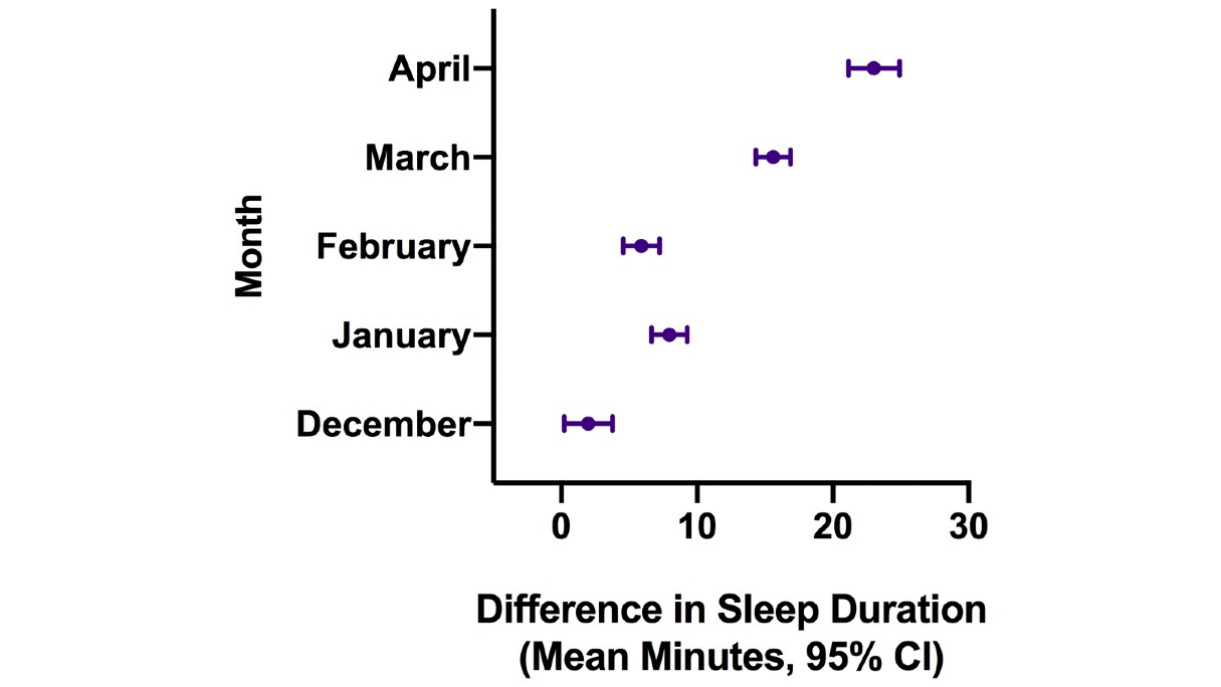
Figure 5. Difference in estimated sleep duration during the COVID-19 pandemic compared to the same month in the previous year in Los